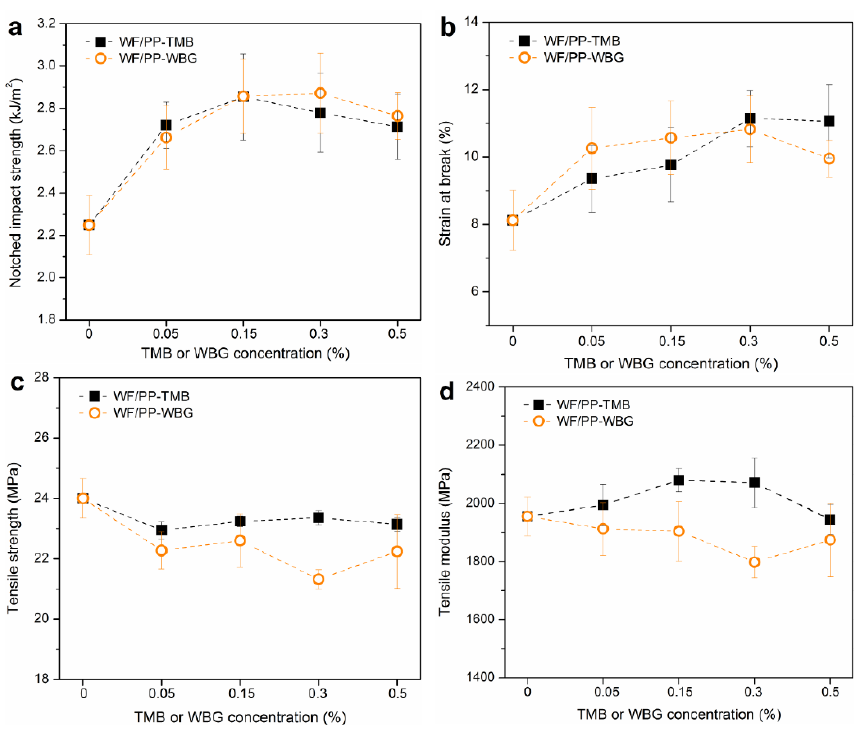
Figure 8. Mechanical properties of WF/PP, WF/PP-TMB and WF/PP-WBG composites: ( a ) Notched impact strength; ( b ) Strain at break; ( c ) Tensile strength; ( d ) Tensile modulus. impact strength; ( b ) Strain at break; ( c ) Tensile strength; ( d ) Tensile